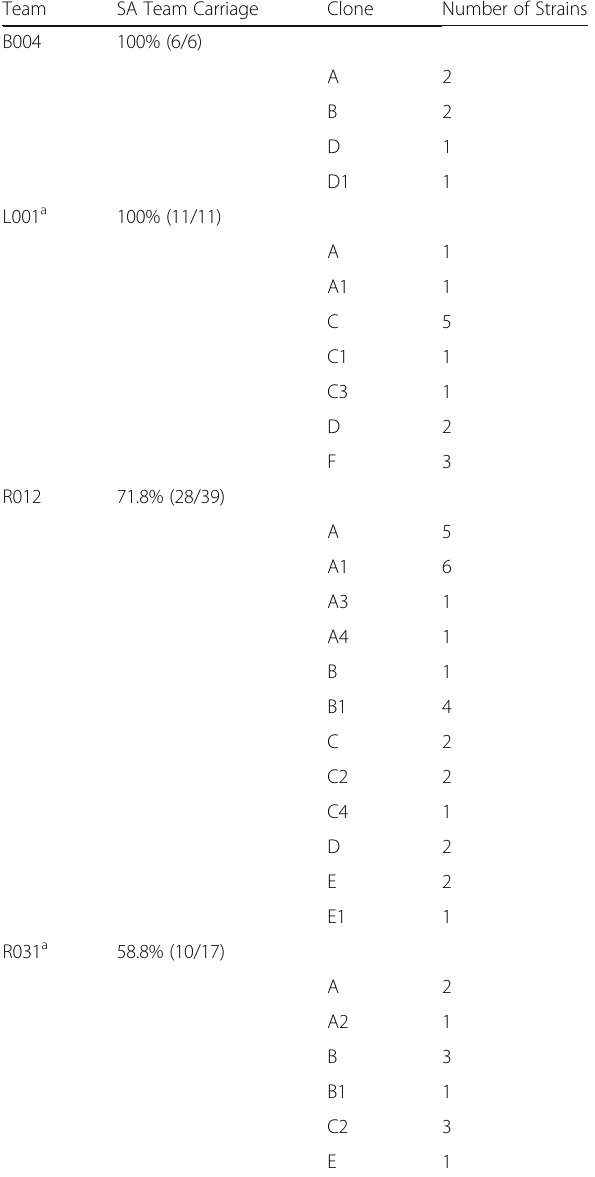
Table 4 Distribution of the SA clones within the Selected Teams